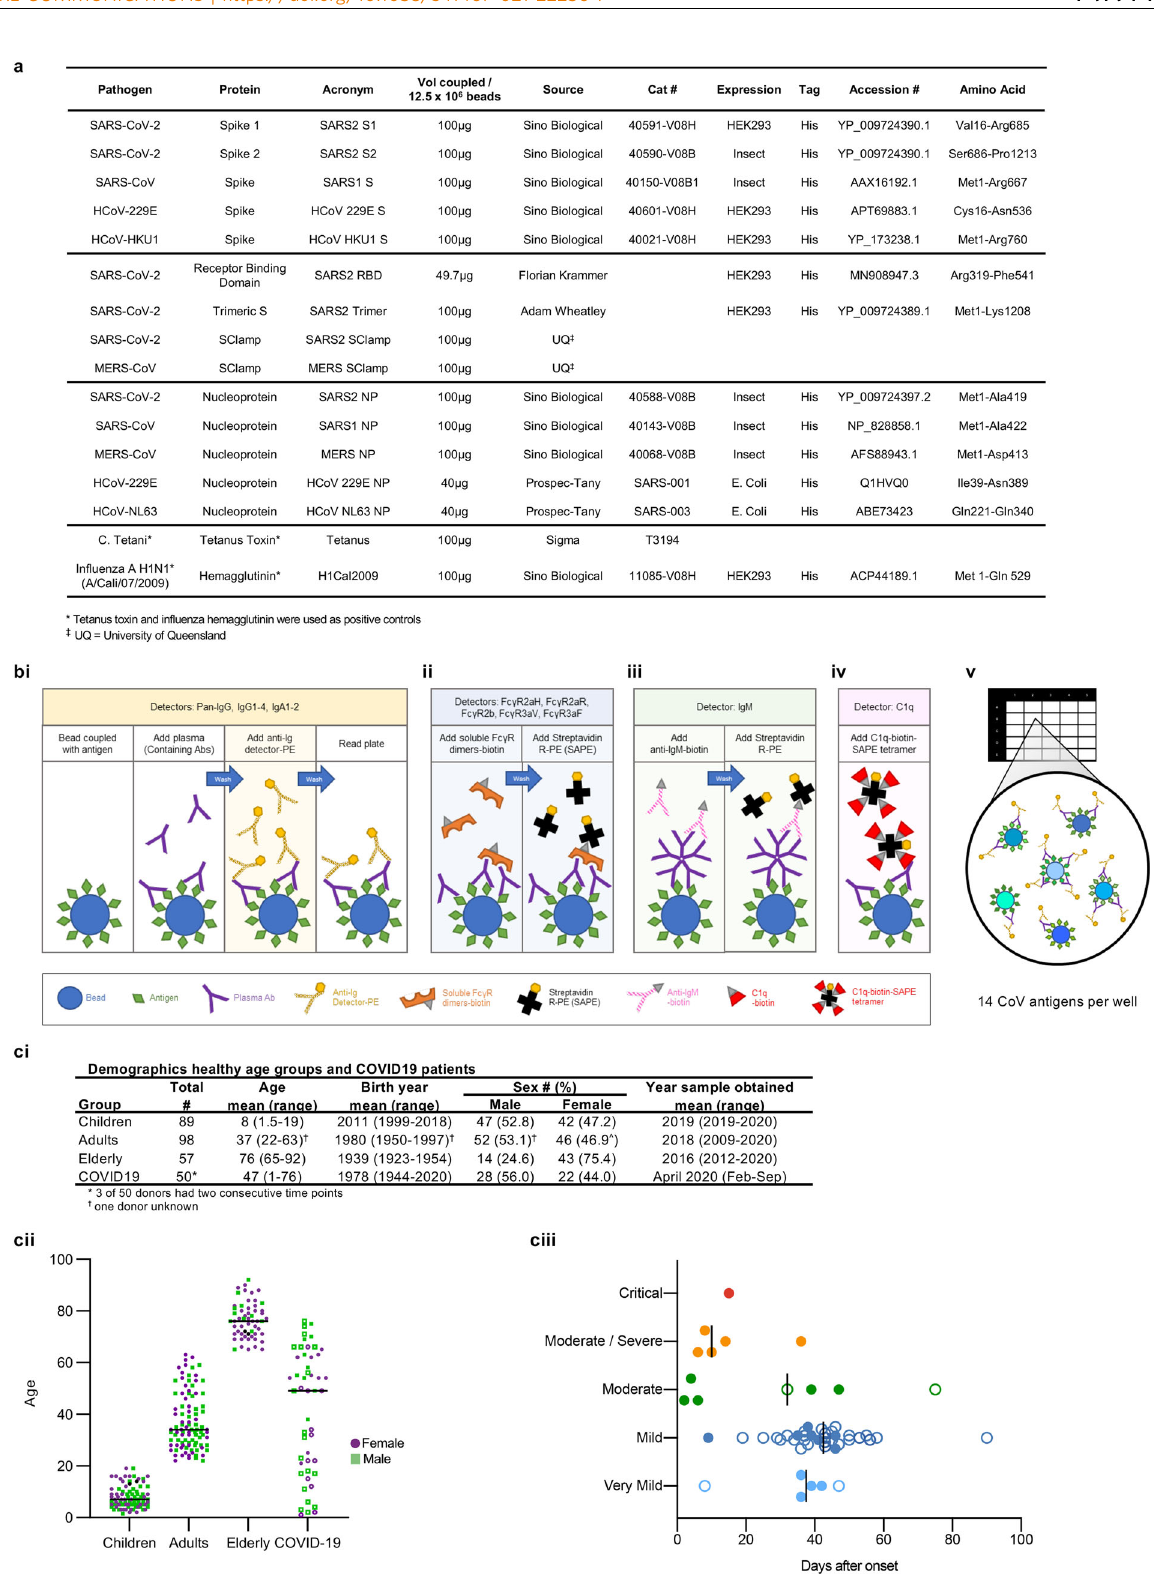
Fig. 1 Cohort information and setup of the custom CoV multiplex. a Details of antigens included in the assay. b Overview of bead-based multiplex assay. Assay setup for detectors Pan-IgG, IgG1-4, IgA1-2 ( b -i), Fc γ R2aH, Fc γ R2aR, Fc γ R2b, Fc γ R3aV, Fc γ R3aF ( b -ii), IgM ( b -iii) and C1q ( b -iv). Fc γ R2aH and Fc γ R3aV are the high-af fi nity variants of the dimers, while Fc γ R2aR and Fc γ R3aF are the respective low-af fi nity dimer variants. ( b -v) Beads coupled to respective CoV antigens are added together into wells of a 384-well plate for multiplexing. c Overview of the demographics in the healthy donors per age group and COVID-19